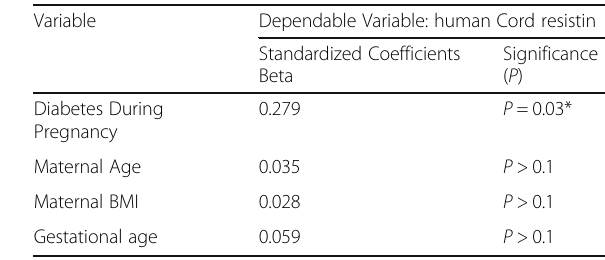
Table 3 Multiple regression analysis on the